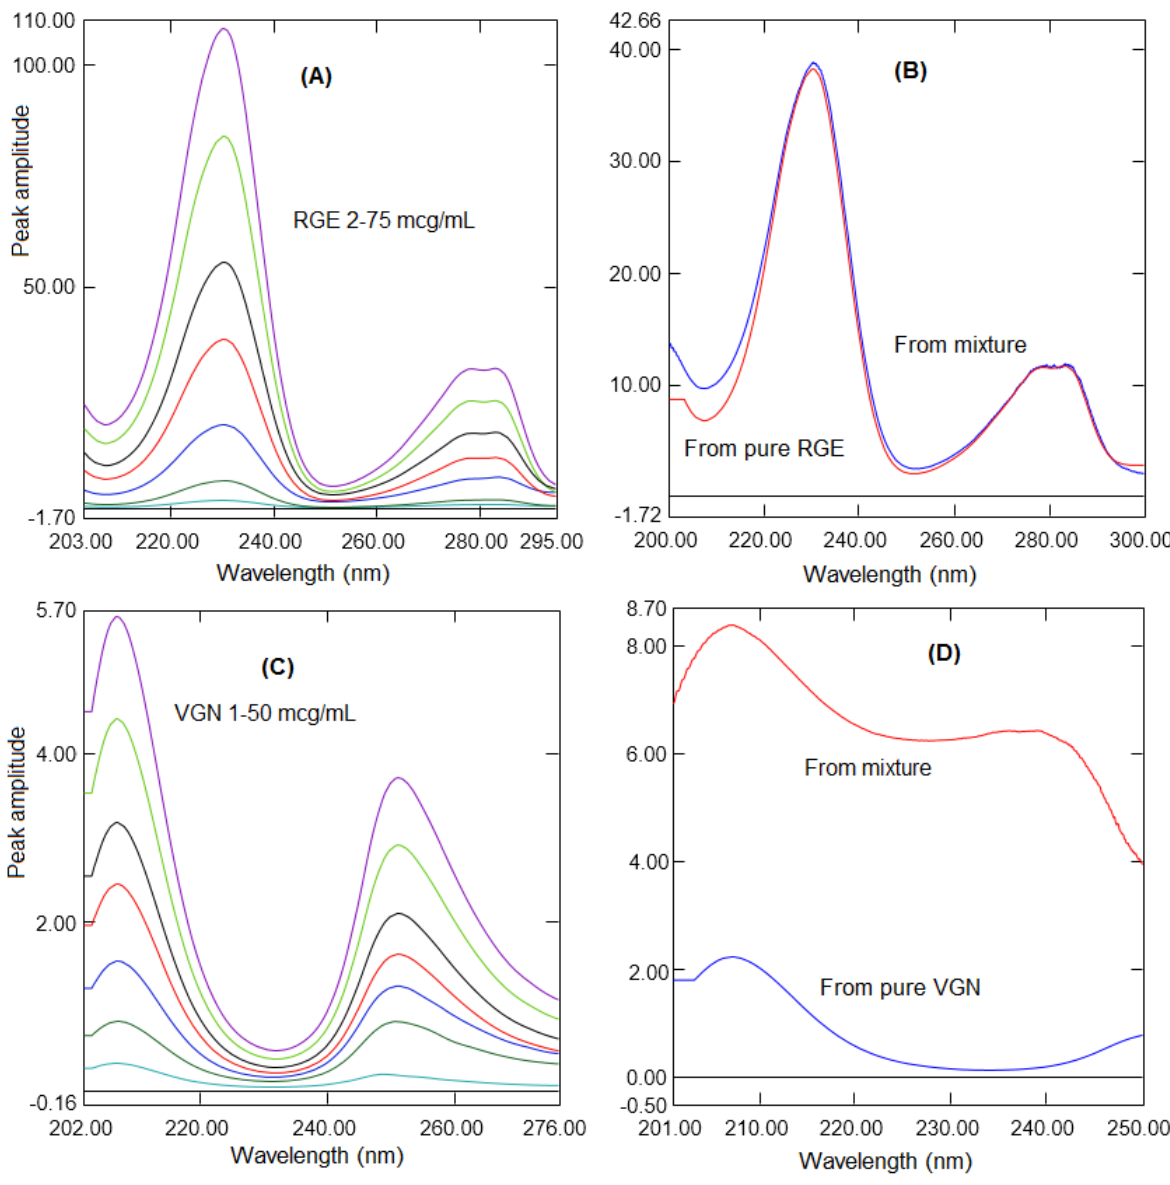
Figure 3. ( A ) Ratio absorption spectra of RGE (2 to 75 µg/mL) using a 5 µg/mL spectrum of VGN. ( B ) Ratio absorption spectra of pure RGE and a mixture. ( C ) Ratio absorption spectra of VGN (1 to 50 µg/mL) using a 5 µg/mL spectrum of RGE. ( D ) Ratio absorption spectra of pure VGN and a mixture.